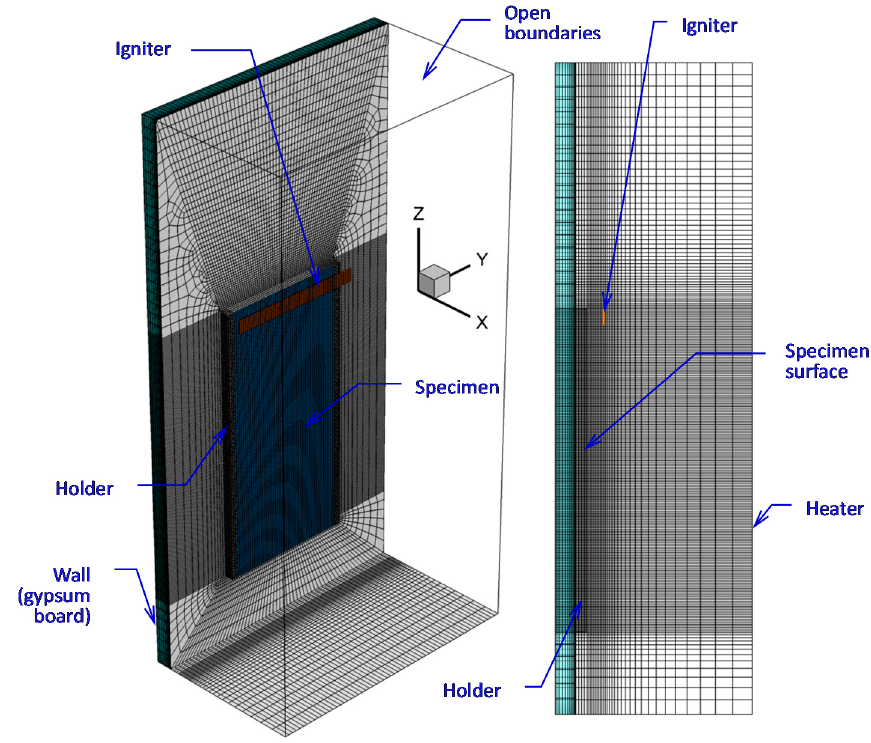
Figure 4. Computational domain and mesh.